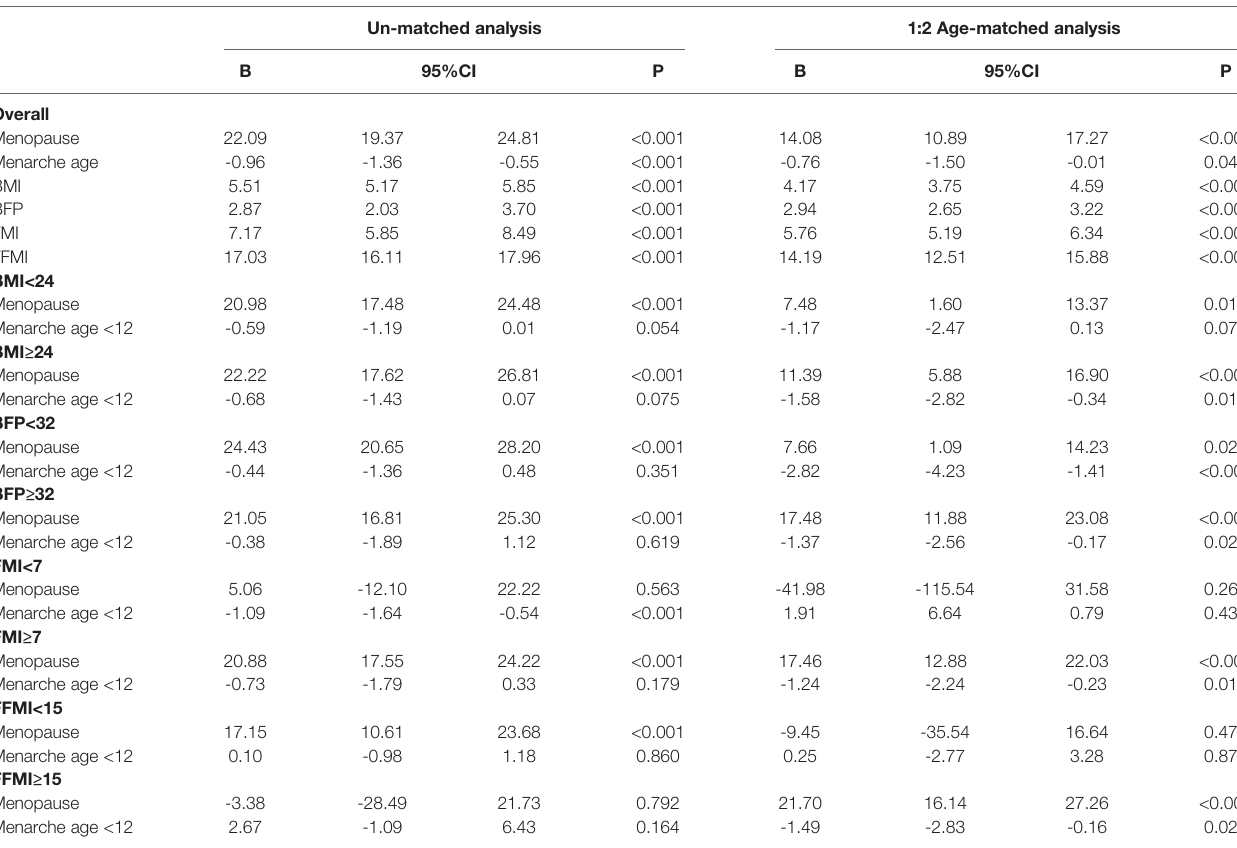
TABLE 2 | The effect of reproductive and body composition factors on serum uric acid among female participants in CNHS. Un-matched